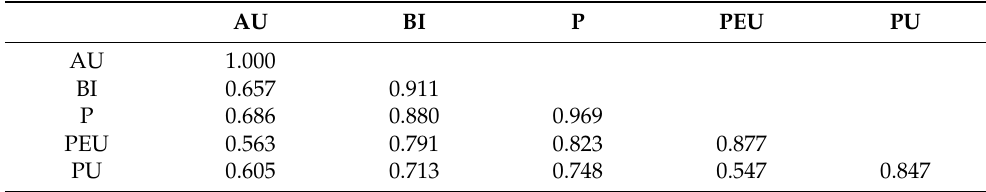
Table 5. Discriminant validity.